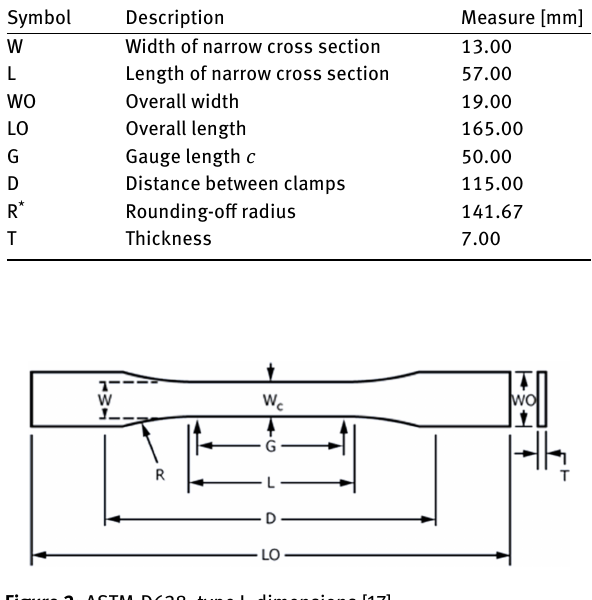
The ASTM-D638 offered five typologies of specimens, each of them characterized by different dimensions. The “Type I” has been chosen for the test considering the pro- duction standards offered by the company Kanésis. Thus, keeping the original size of the specimens, a parabolic pro- file was proposed, continuous and tangent to the shorter section. The Italian start-up Kanésis printed the HBP (cid:114) spec- imen (code: PLA A/17 NAT) by the 3D-printer in order to produce 5 specimens for each type.